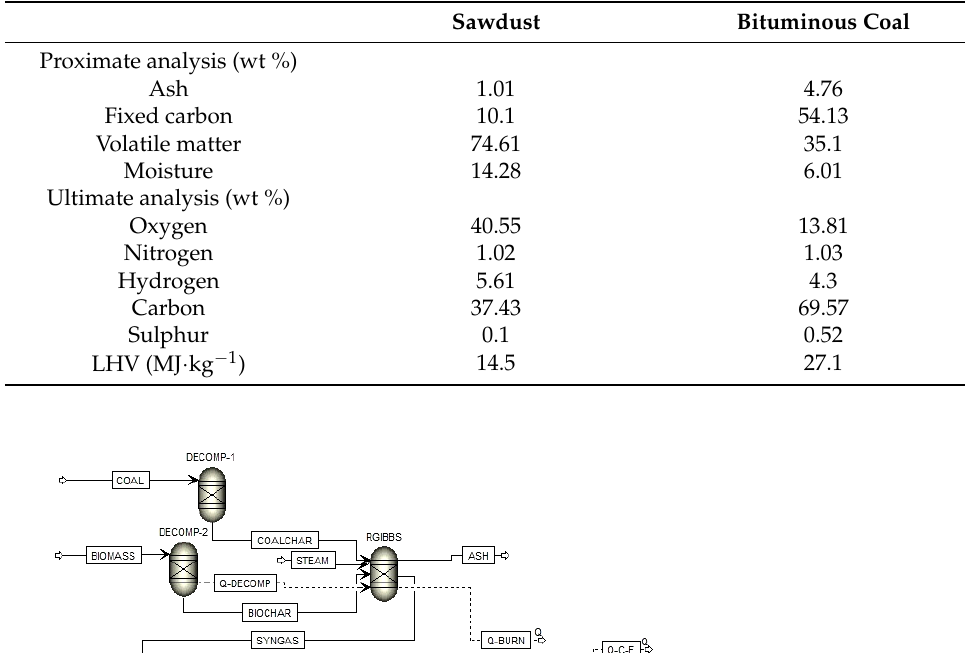
Table 1. Properties of the bituminous coal and sawdust [23].